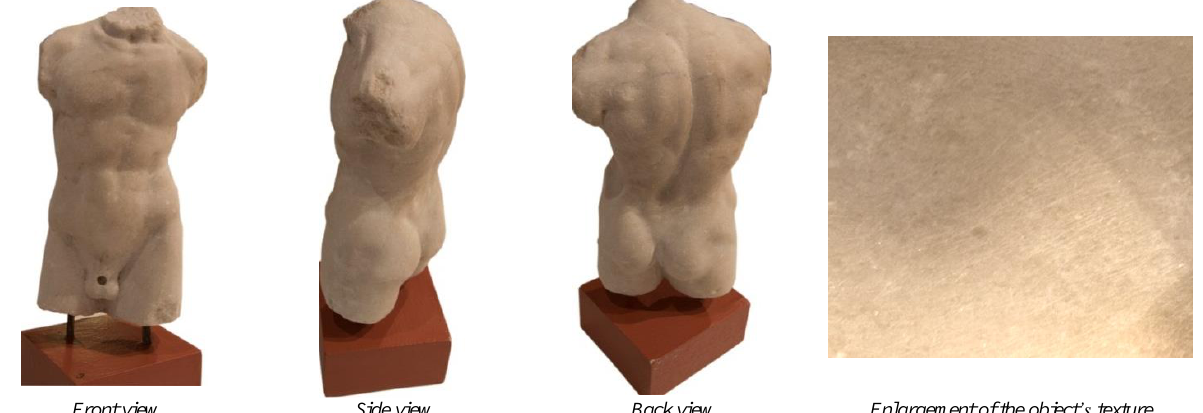
Figure 2: Marble male torso (Collections of Castello del Buonconsiglio Museum, Trento, Italy).